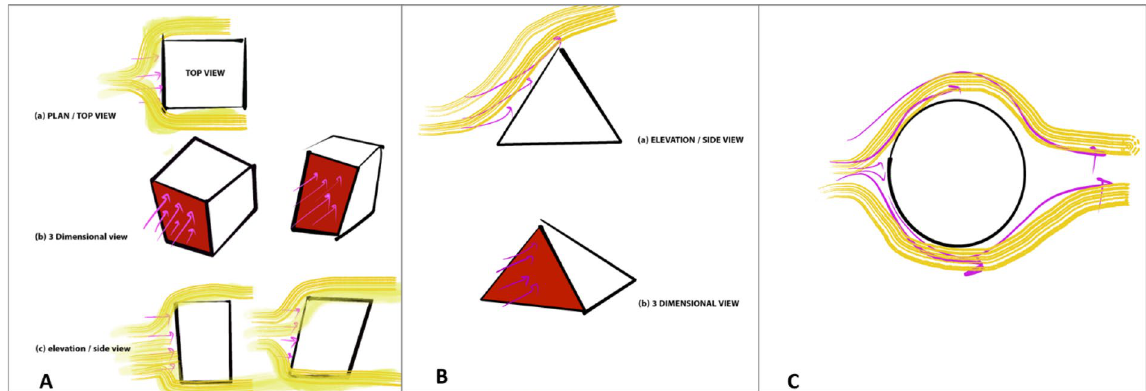
Fig. 8 a Effect of lateral load on square fixed structure; b Effect of lateral load on Triangular fixed structure; c Effect of lateral load on circular surface